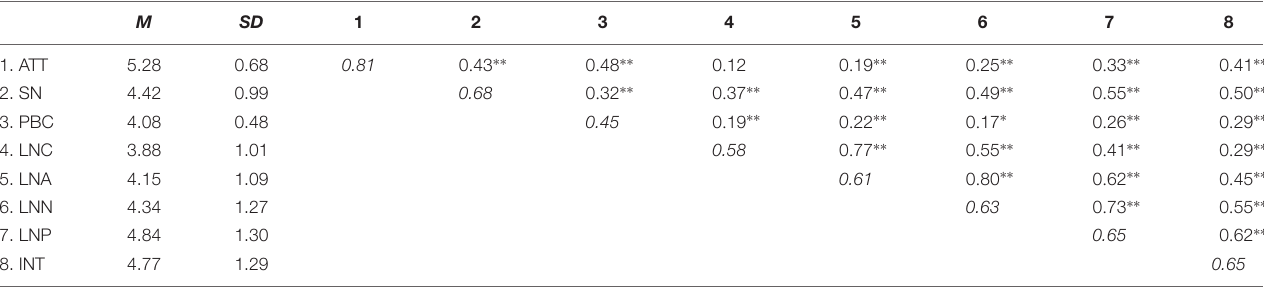
TABLE 4 | Means ( M ), standard deviations ( SD ), reliability coefficients and bivariate correlations among the overall measures of attitudes (ATT), subjective norms (SN), PBC, local norms (LNC, LNA, LNN, and LNP), and intentions (INT), computed on sample 1 ( N = 222). M SD